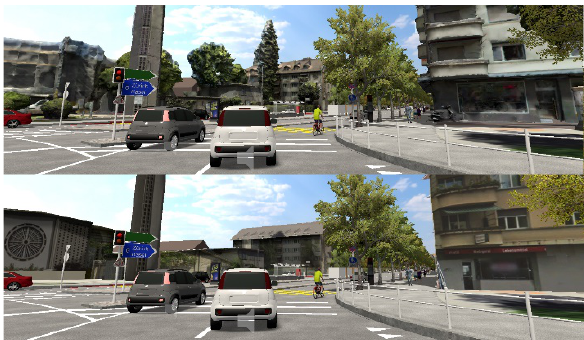
Figure 12. VR view using the two different building models produced. above: the automatic reconstruction with MMS data (dense mesh), below: city models (low poly) textured with georeferenced MMS